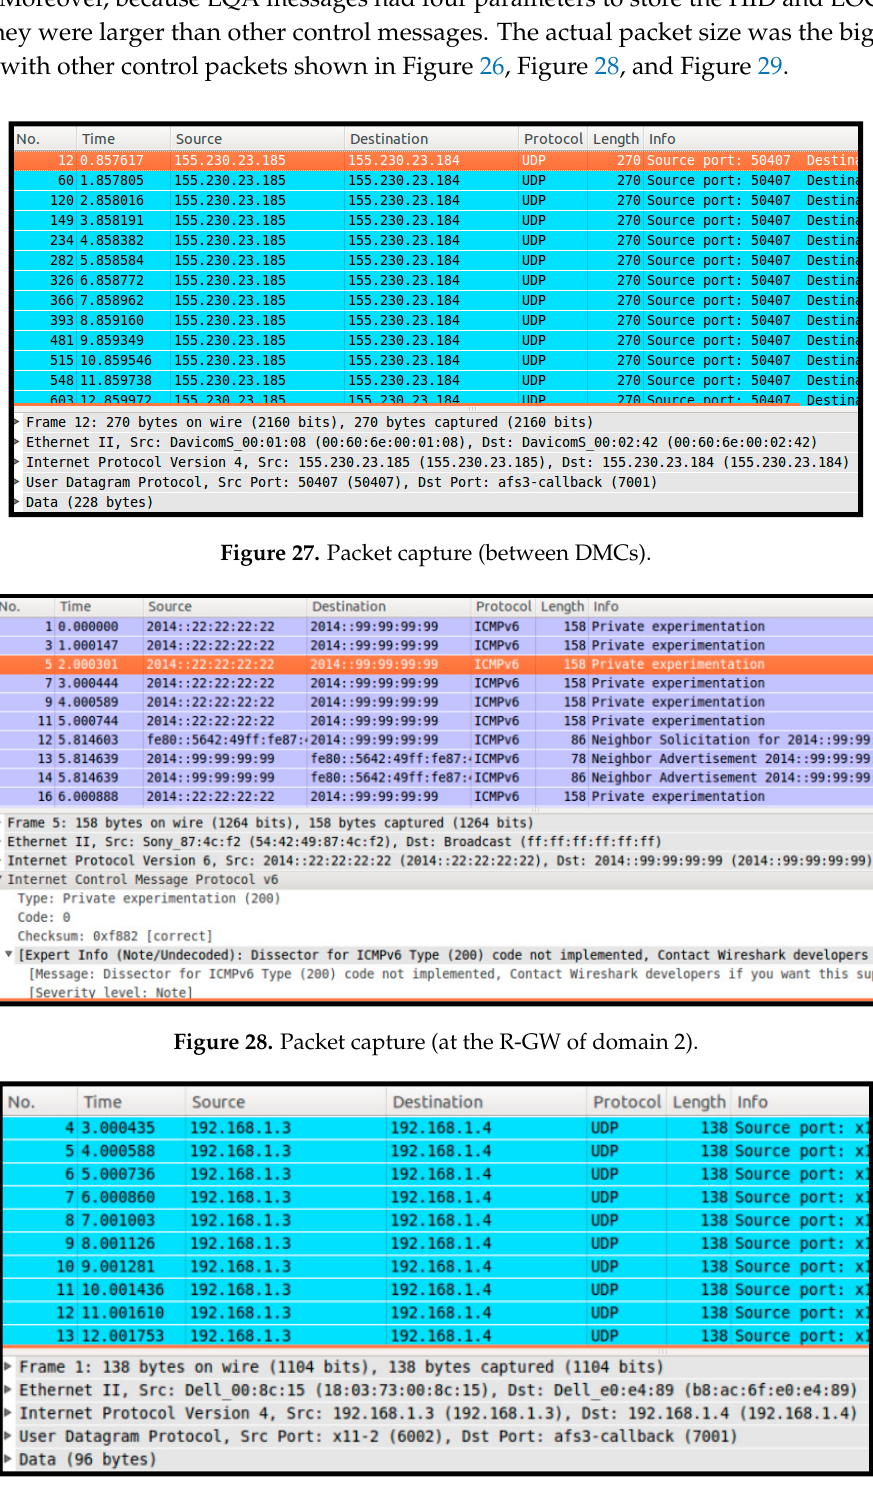
Figure 29. Packet capture (at R ‐ GW of domain 1).